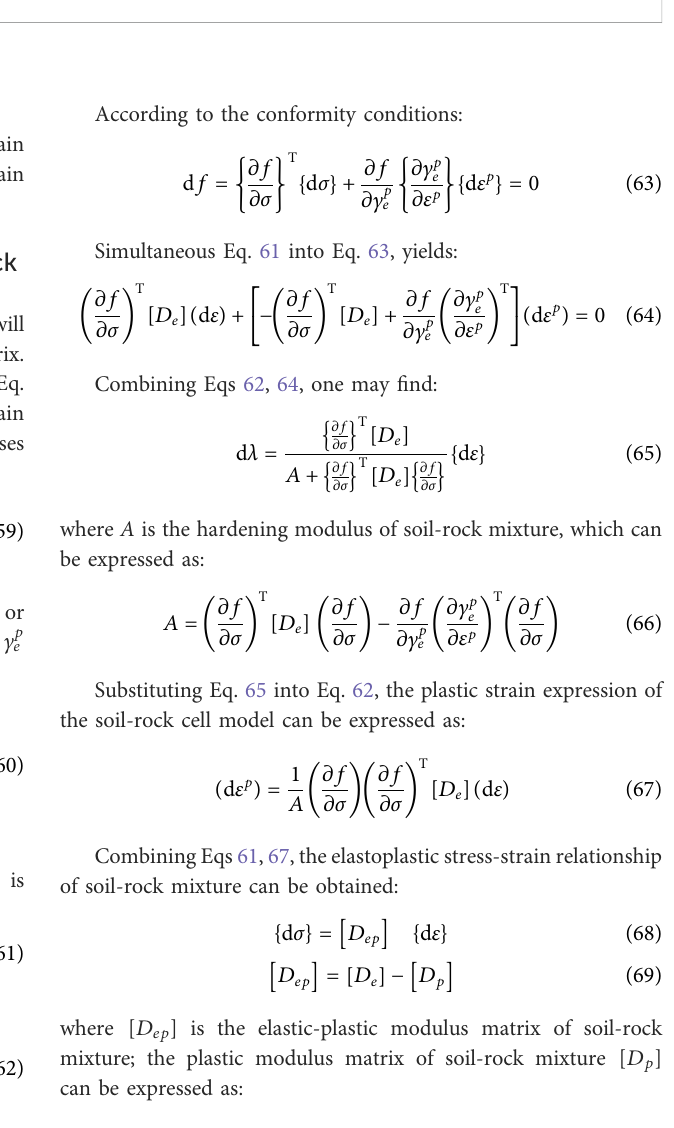
FIGURE 4 The programming framework of the multiscale fi nite element method based on ABAQUS